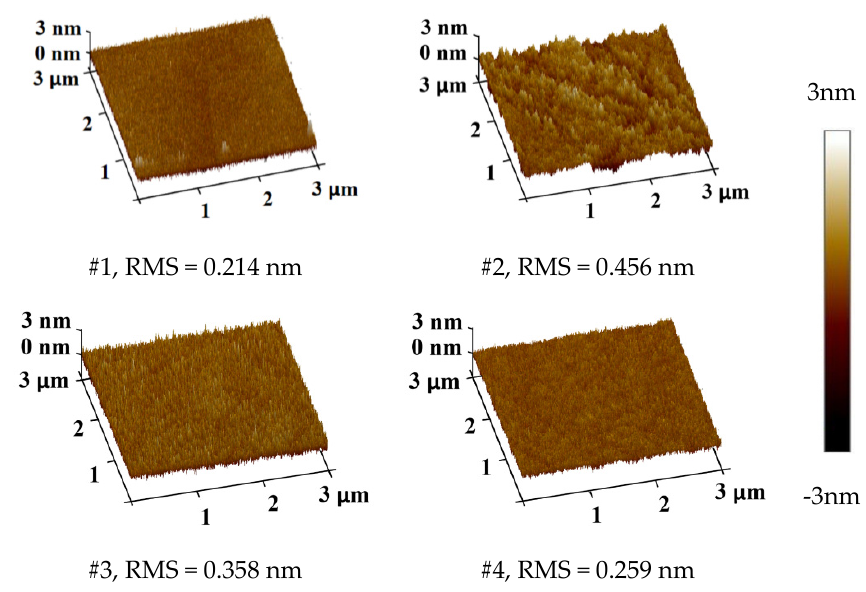
Figure 7. Surface roughness values of the post-treatment samples.